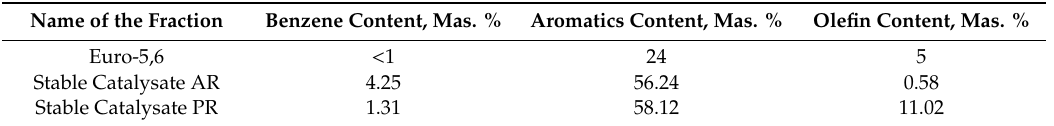
Table 1. The content of benzene and aromatic hydrocarbons in gasoline fractions of AR and PR in comparison with